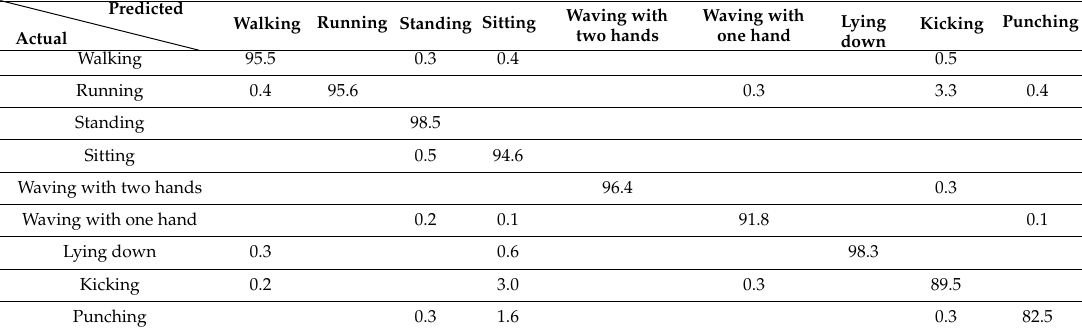
Table 8. Confusion matrix of the results of behavior recognition by our method (unit: %).